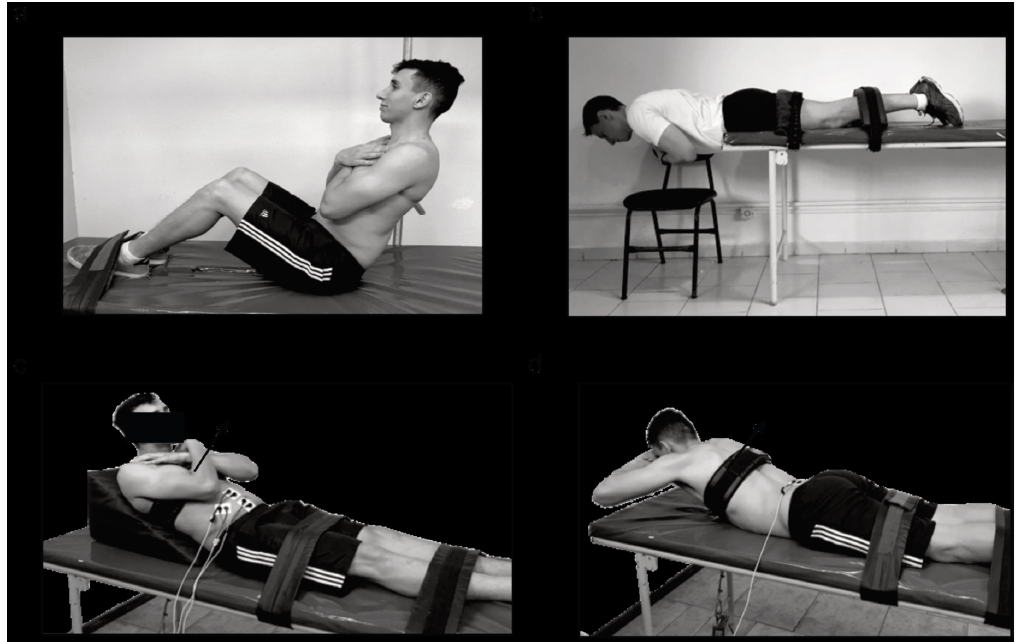
Figure 1. Representation of the assessment of the endurance test of the trunk flexor (upper left panel), and extensor (upper right panel) muscles, and the peak torque of the trunk flexor (lower left panel) and extensor (lower right panel) muscles.